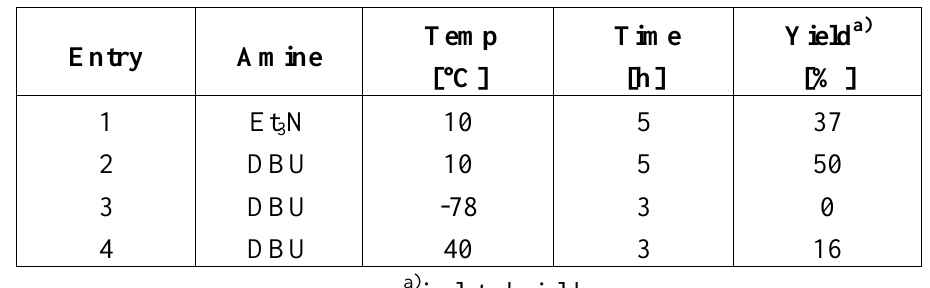
Table 3. Bayliss-Hillman Reaction of p-Nitrobenzaldehyde with